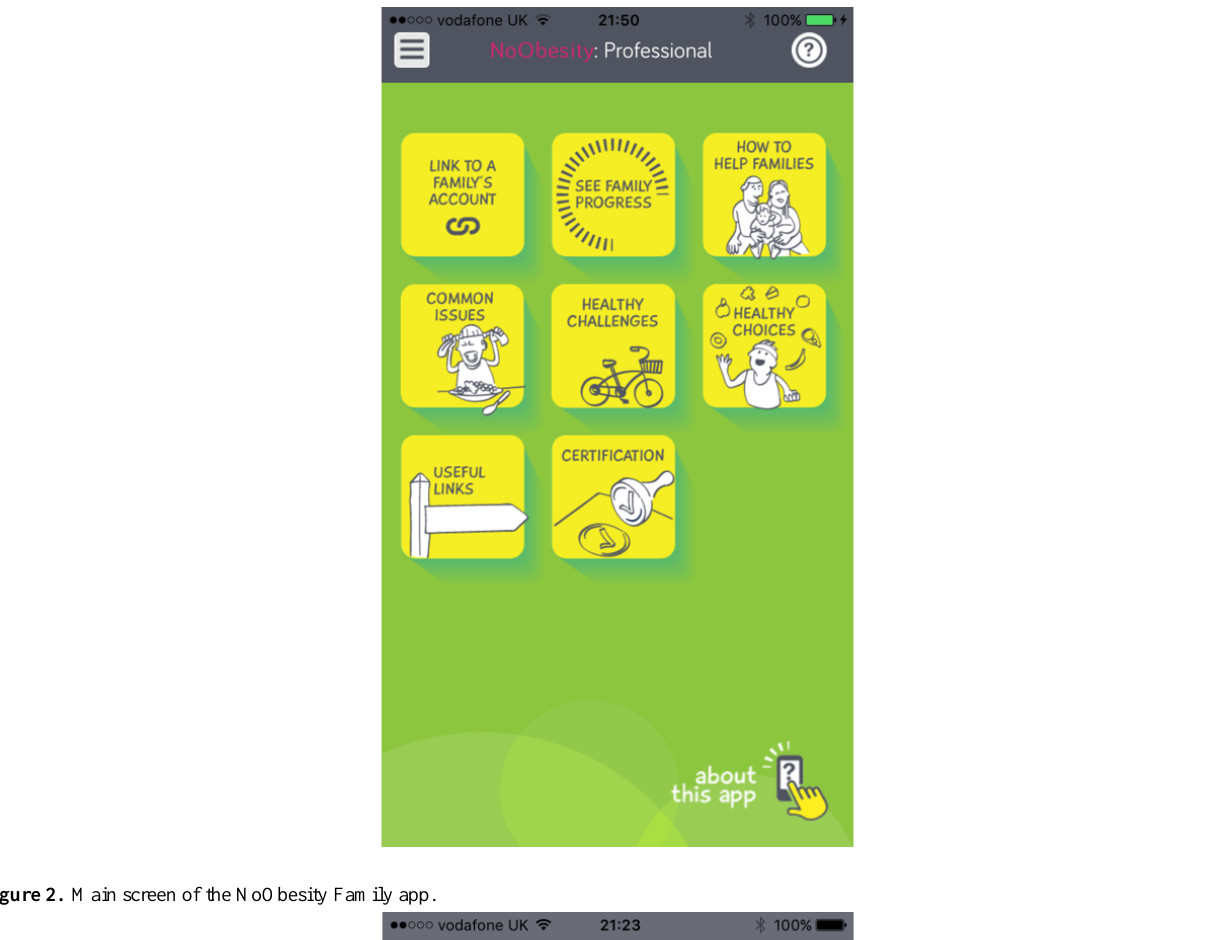
Figure 1. Main screen of the NoObesity Professional app.